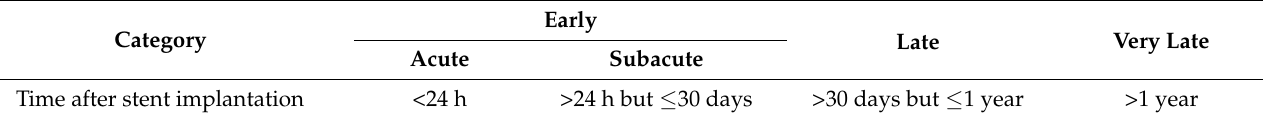
Table 1. Categories of stent